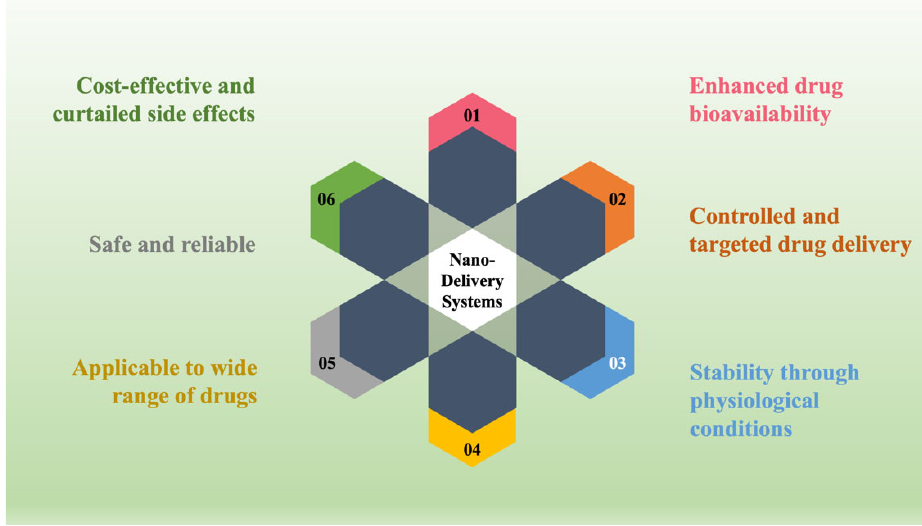
Figure 1. The ideal characteristics of nano delivery systems.